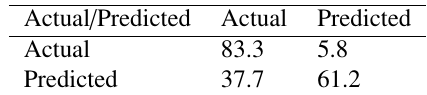
Table 1. CONFUSION MATRIX OF THE EXISTING